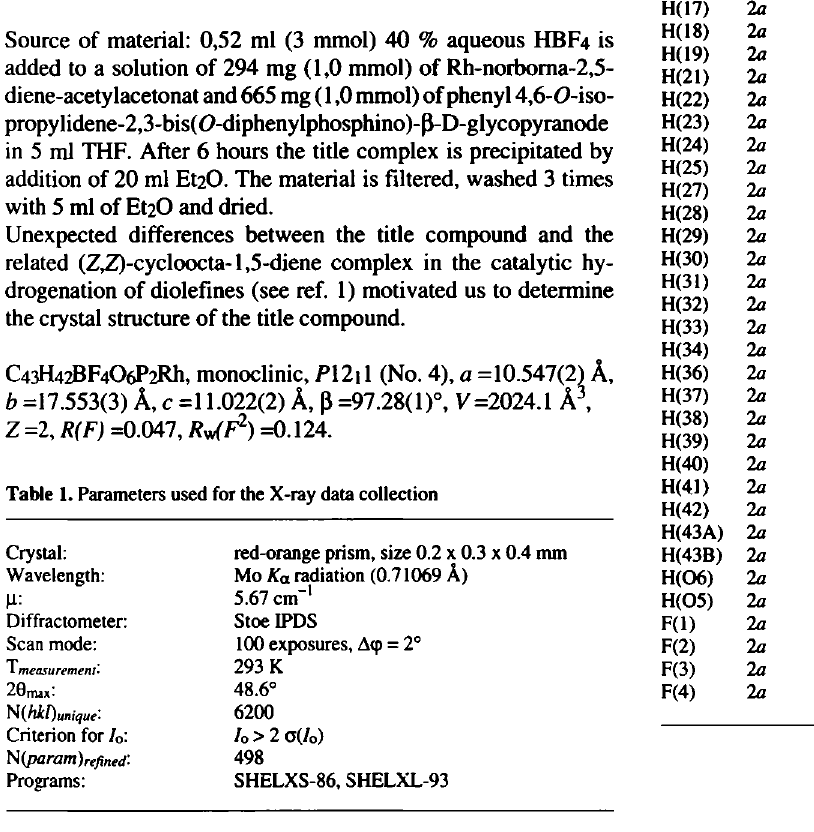
Table 1. Parameters used for the X-ray data collection